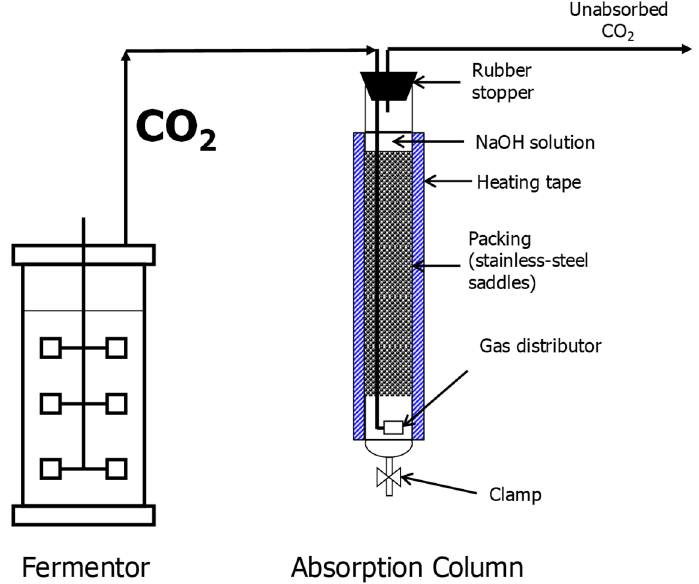
Figure 1. Schematic diagram of the apparatus used for the capture of CO 2 from sweet sorghum juice (SSJ) ethanol fermentation by absorption in 5 M NaOH.